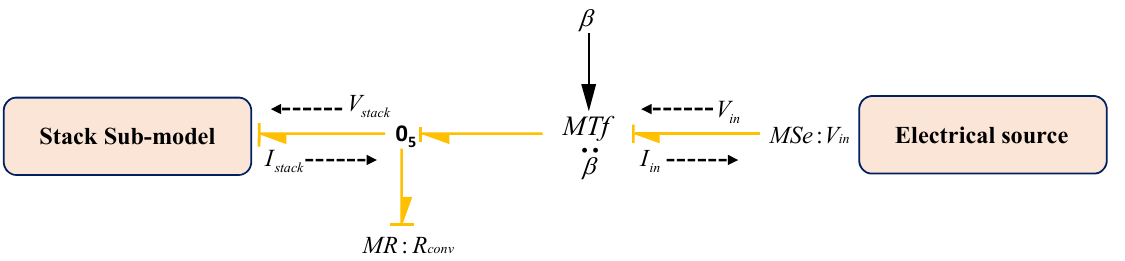
Figure 14. BG sub-model of converter